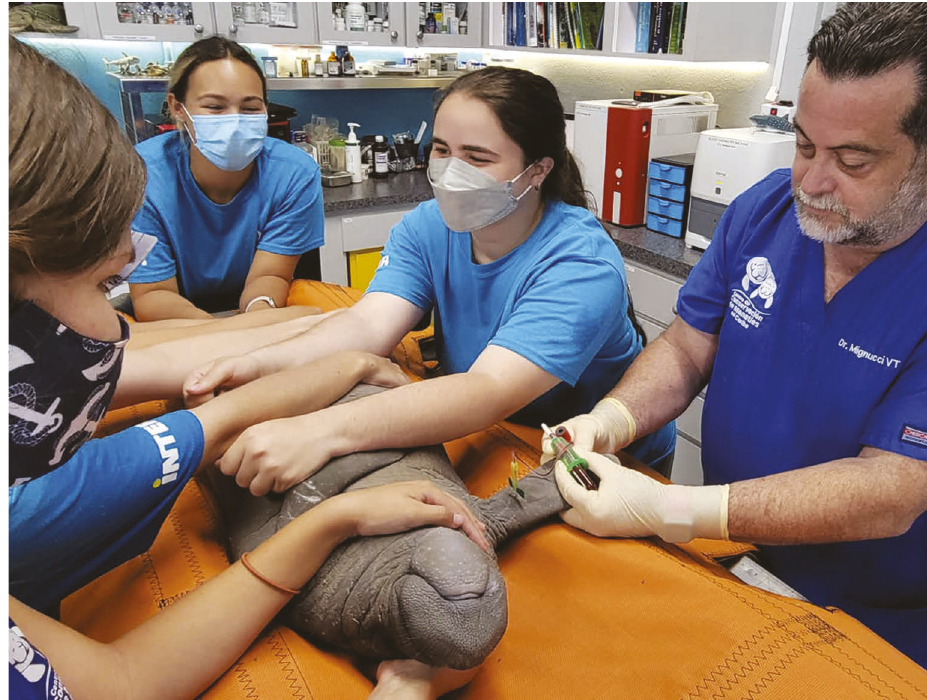
Figure 3: Venipuncture sampling on a calf Antillean manatee from Puerto Rico using a 21-gauge X 3/4-inch needle with a vacutainer and a “butterfly” set”.